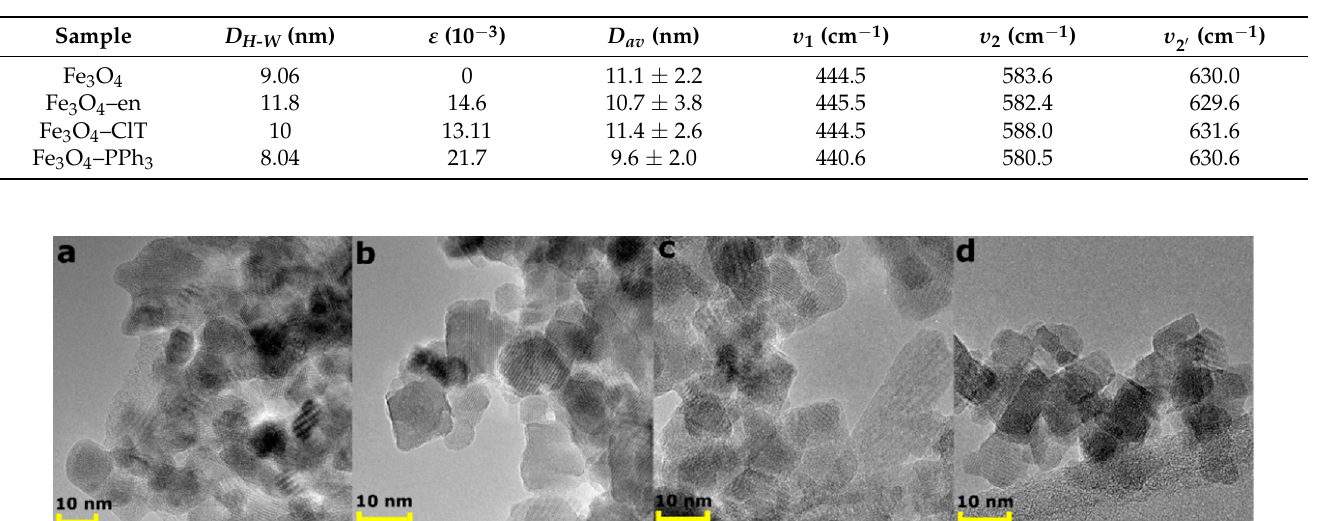
Table 1. The average crystallite size ( D H-W ), intrinsic strain ( ε ), average particle size ( D av ), and characteristic for Fe–O bonds vibrations ( υ 1 , υ 2 , and υ 2 (cid:48) ).